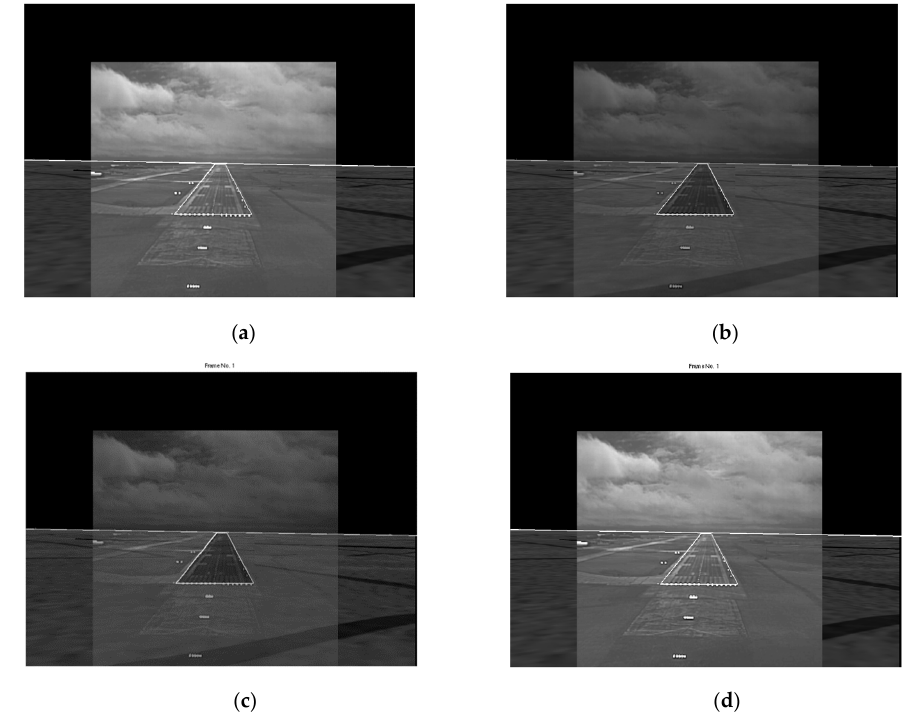
horizons are aligned; ( b ) EVS and SVS horizons and center lines are aligned.